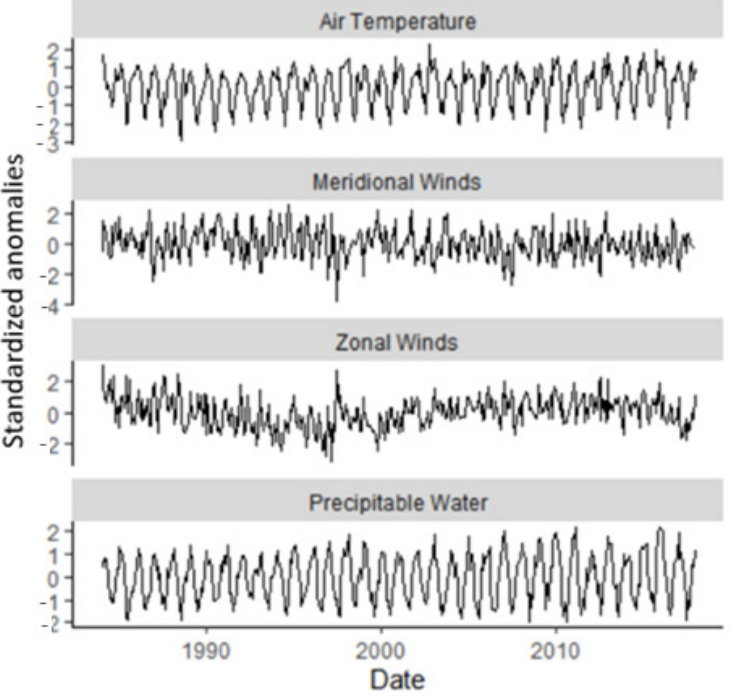
Figure 4. Standardized anomalies climate variables time series for air temperature, meridional wind,